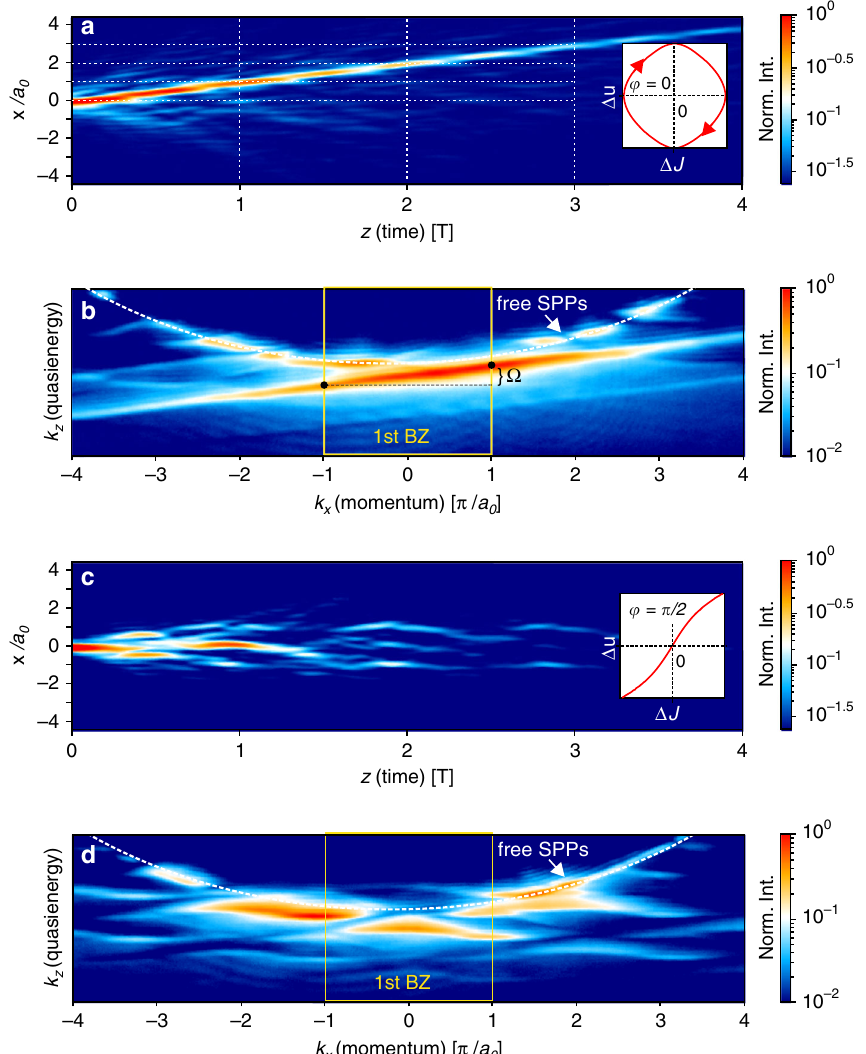
Fig. 5 Observation of fast Thouless pumping in a DLSPPW array. a Real-space SPP intensity distribution for u 0 = 1.1 J 0 , γ 0 = 0.8 J 0 , and φ = 0. Plot on the right shows the projection of the corresponding pumping cycle onto the plane ( J 1 − J 2 , u a − u b ). b Fourier-space SPP intensity distribution corresponding to a . c Real-space SPP intensity distribution for u 0 = 1.1 J 0 , γ 0 = 0.8 J 0 , and φ = π /2. Plot on the right again shows the corresponding cycle in parameter space. d Fourier-space SPP intensity distribution corresponding to c